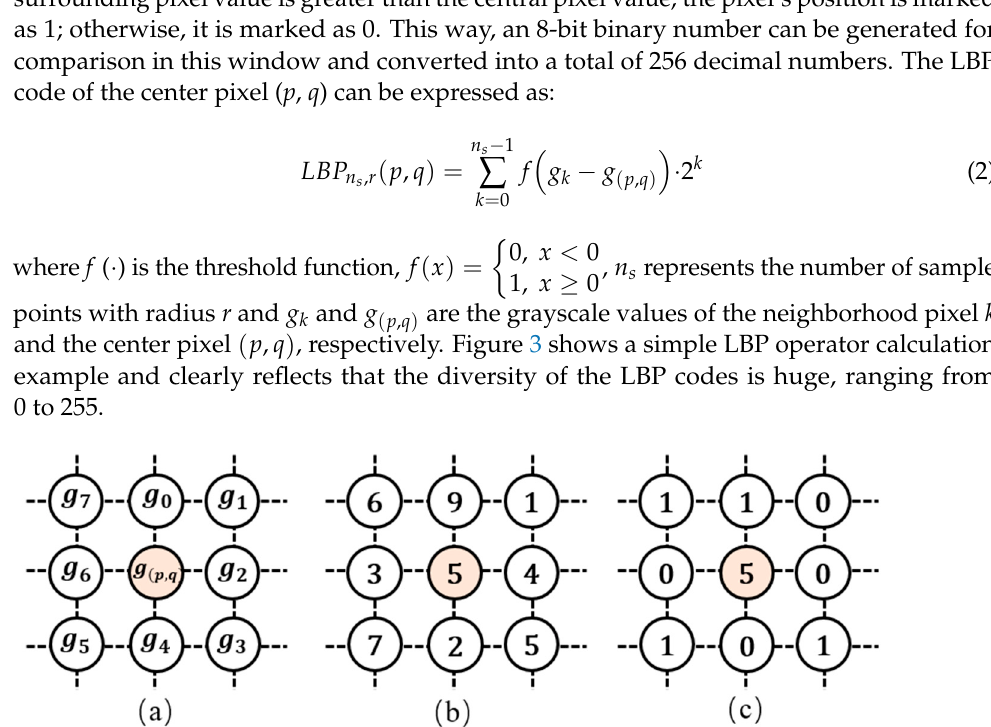
Figure 3. LBP operator in 3 × 3 neighborhood, where ( a ) center pixel g ( p , q ) with eight neighbors, ( b ) sample block, ( c ) binary labels of eight neighbors.